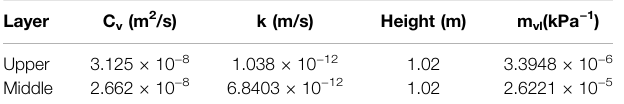
TABLE 2 | Model parameters ( m vl (cid:1) 1/ E s ) .